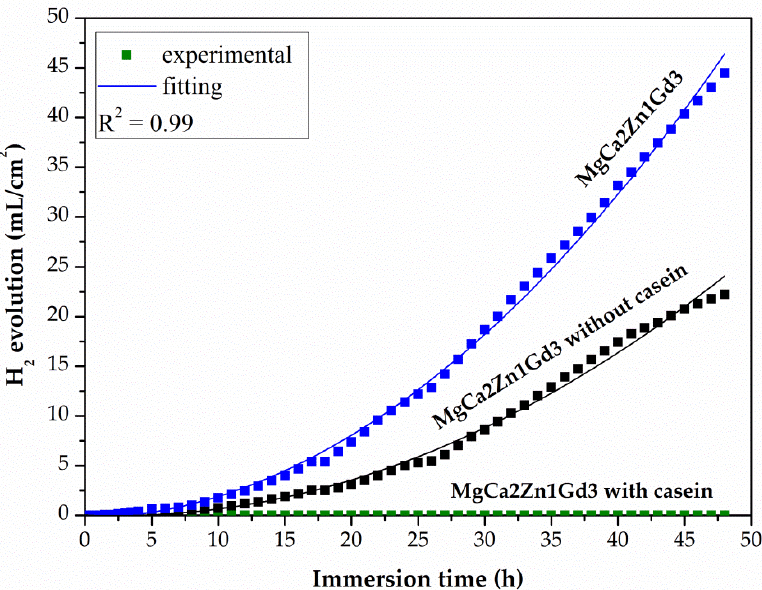
Figure 12. Volume of hydrogen evolution as a function of immersion time in Ringer solution at 37 °C during 48 h for the coatings applied to the MgCa2Zn1Gd3 alloy and uncoated alloy.